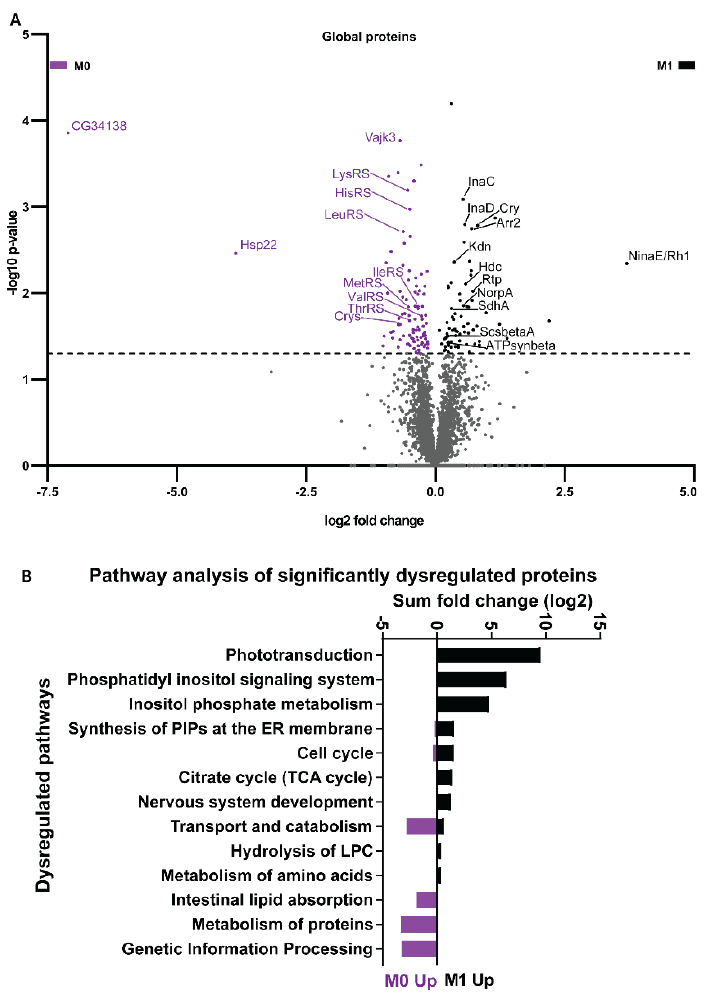
Figure 4. The eye proteome of wild type Drosophila melanogaster raised on synthetic M1 diet (contains vitamin A precursor) or synthetic M0 diet (lacks vitamin A precursors). ( A ) Label-free global eye proteome analysis. The volcano plot shows differentially expressed proteins between M1 diet (black) and M0 diet (purple) in the Drosophila eye. The statistical cut-off ( p -value -log10 1.3, equivalent to p < 0.05) is indicated by the dashed line. ( B ) Pathway enrichment analysis of differentially expressed proteins in the eyes of flies raised on M1 diet or M0 diet. Note that the pathways ‘phototransduction’ and ‘citrate cycle’ were significantly downregulated in the absence of vitamin A, while ‘metabolism of proteins’ was upregulated.